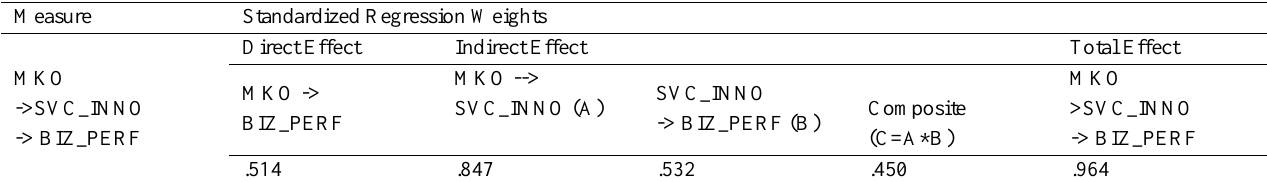
Table 4: Estimate of standardized regression weights and effect analysis Measure Standardized Regression Weights